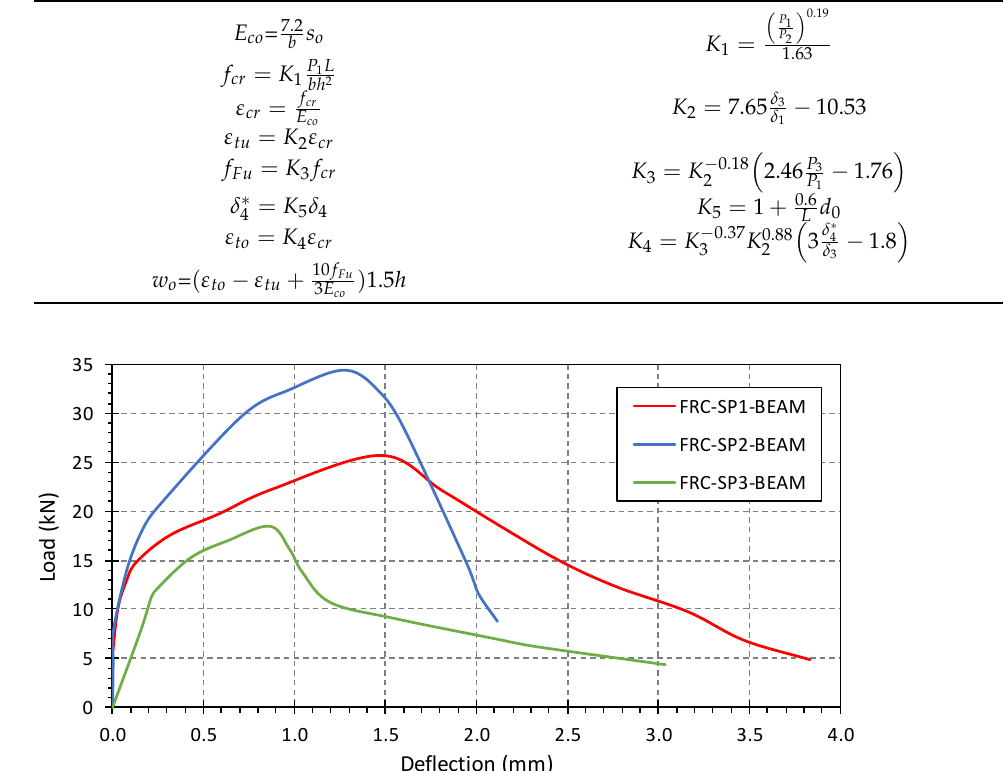
Figure A1. Representative load vs. deflection envelope curves from four-point bending tests.